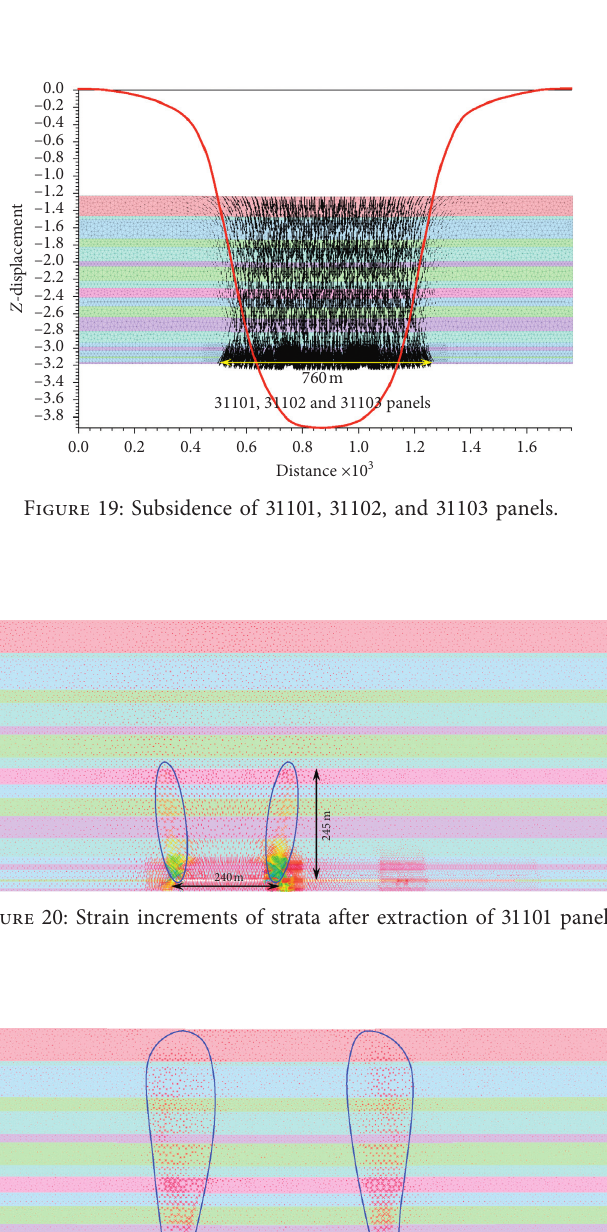
Figure 21: Strain increments of strata after extraction of 31101 and 31102 panels. Inc. Scale: 104.624 Minimum prin.